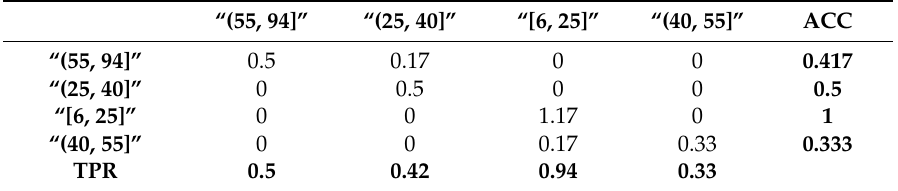
Table 4. Confusion matrix for total UPDRS prediction with PDQ, AIMS, and Epworth attributes. Column headers represent predicted values, and row headers represent actual values.